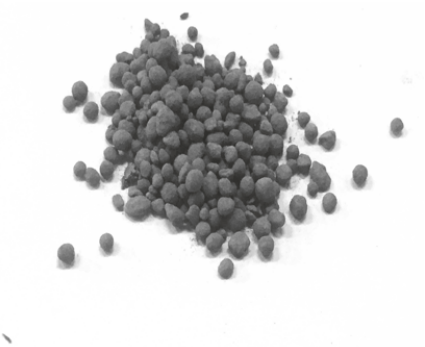
Figure 13: Sphere shape.